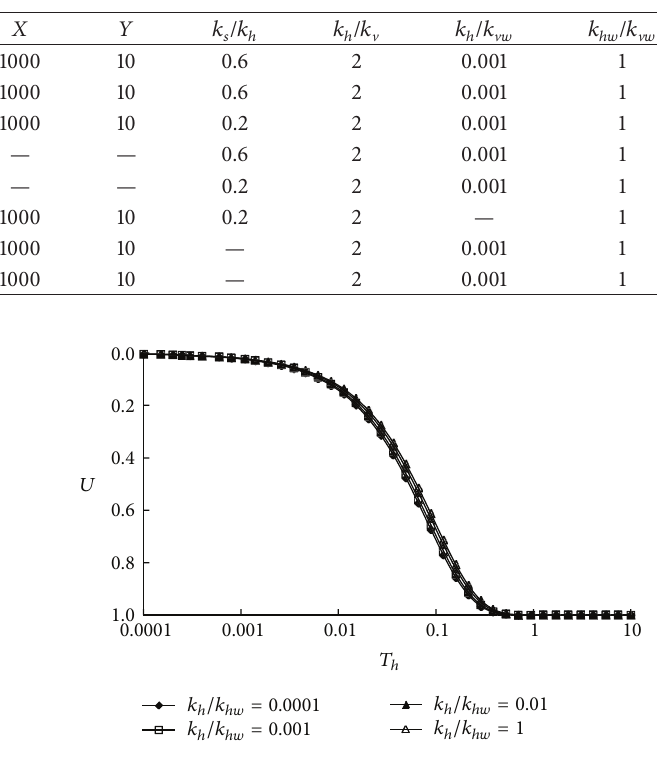
Figure 8: Influence of 𝑘 ℎ / 𝑘 ℎ𝑤 on consolidation process.